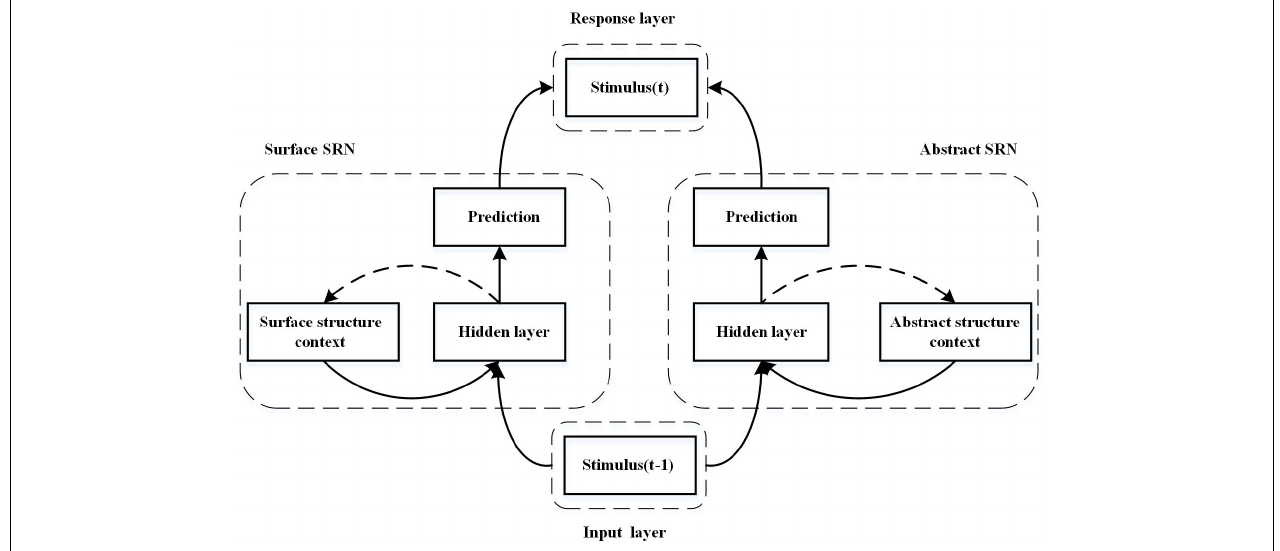
FIGURE 2 | Schematic diagram of the dual simple recurrent network (DSRN). The left SRN encodes the sequence context and learns to predict the next stimuli, whereas the right SRN encodes the abstract structures in the stimuli sequence and learns to predict the abstract structure of the next stimulus. The predictions of the two SRNs are integrated in a response